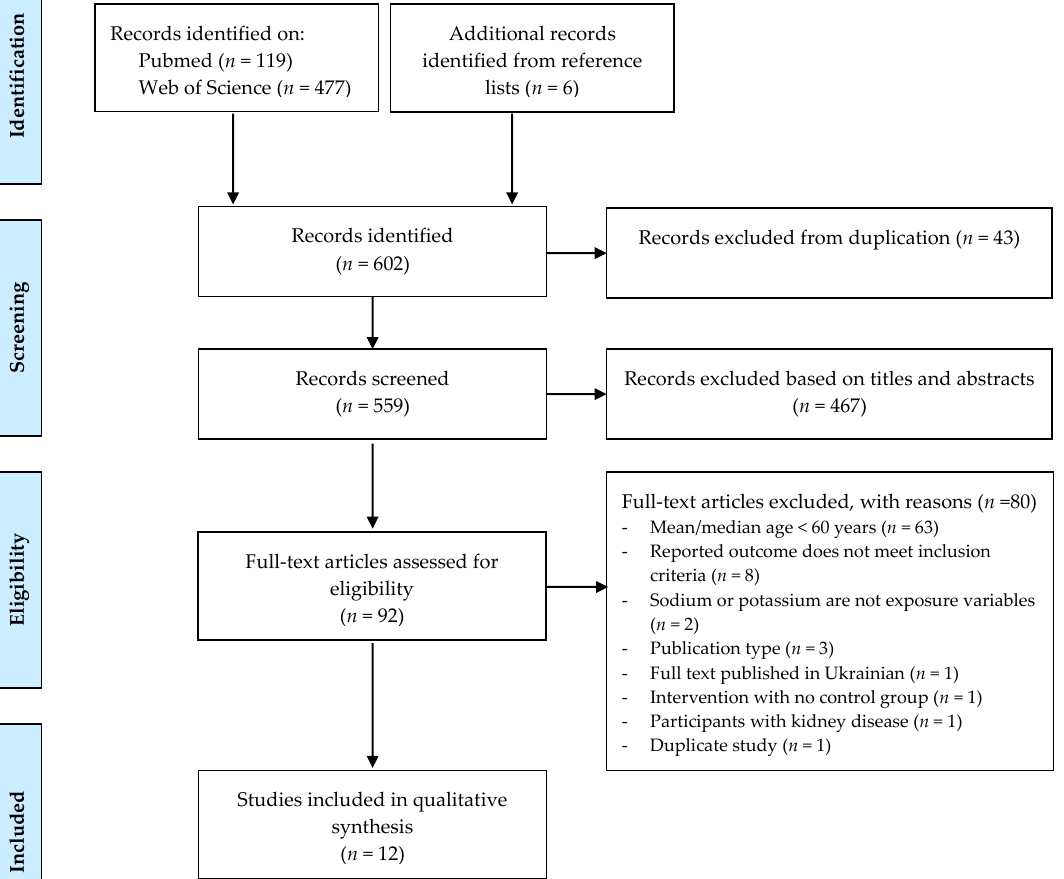
Figure 1. Flowchart of systematic literature search for inclusion in the review of relationship of sodium and potassium intake and cardiovascular disease among older